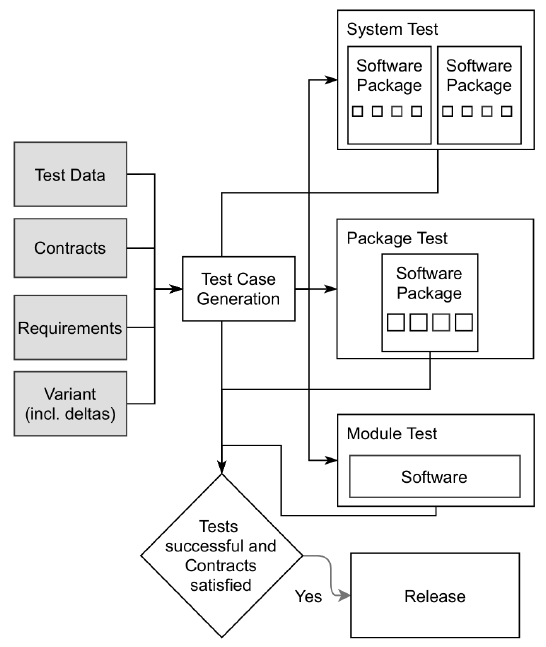
Figure 8. Variant Aware Software Test before Release of the